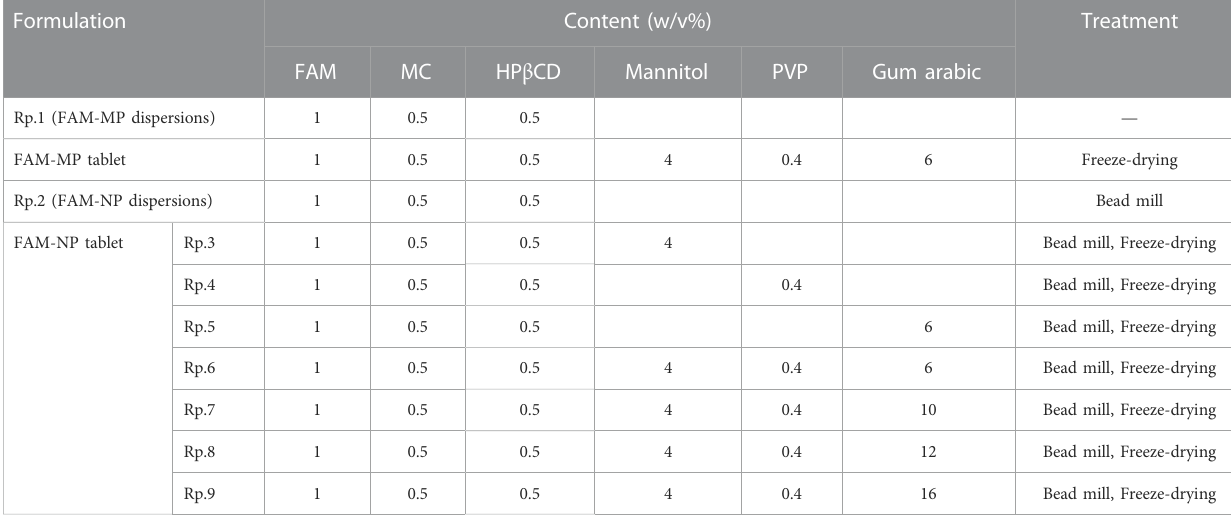
TABLE 1 Compositions of FAM dispersions and tablets used in this study.